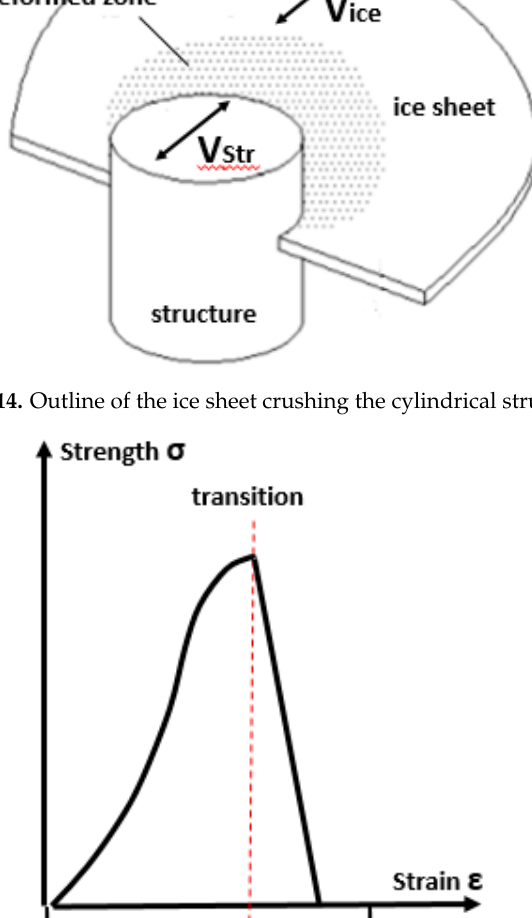
Figure 16. The ice-resistant modification of the platform.